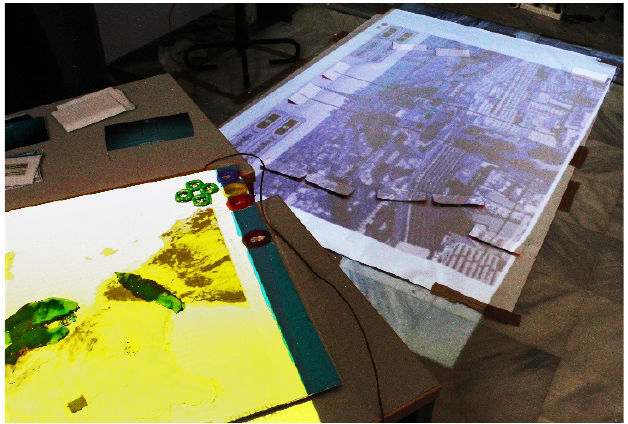
Fig. 2. Robotics track with EV3